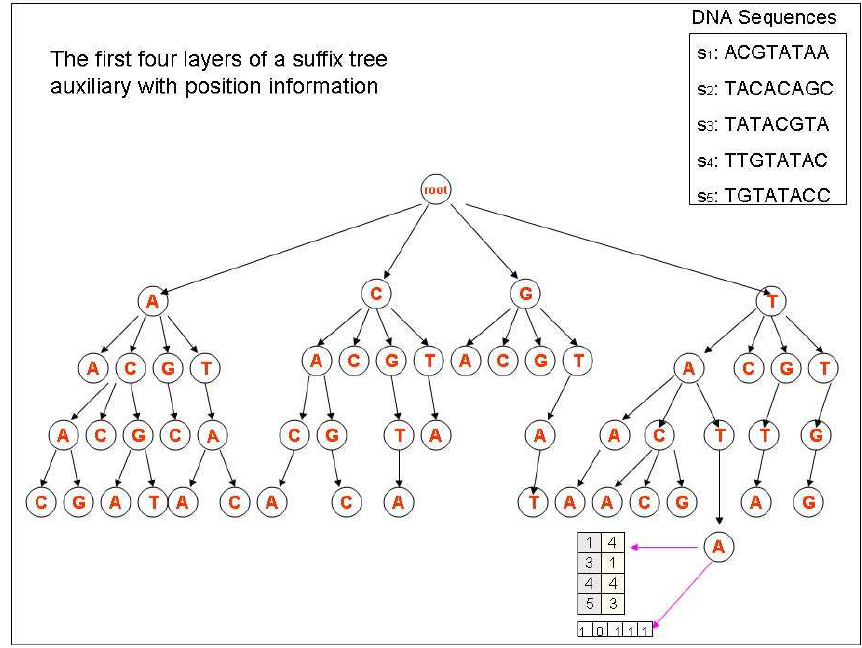
Figure 2: The first four levels of the suffix tree for the sample S= { s1, s2, ··· , s5